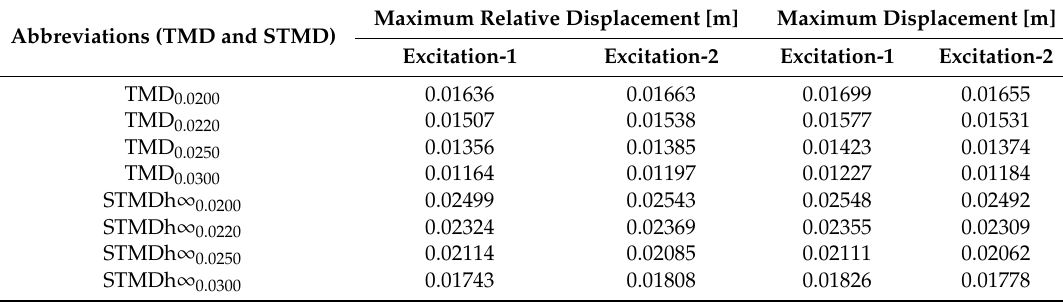
Table 4. Displacements and relative displacements of the STMDh ∞ and the